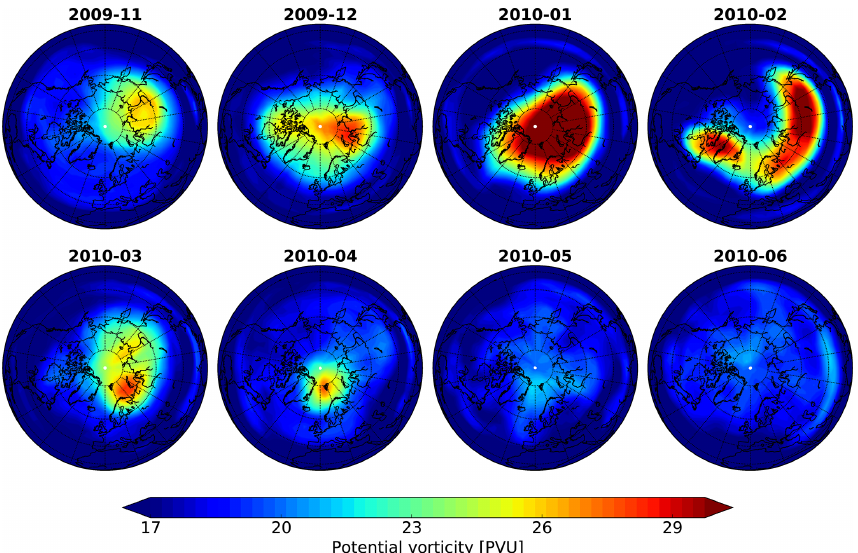
Figure 8. Mean monthly potential vorticity on the 450K isentropic surface from the archived GEOS-5 meteorological fields (north pole